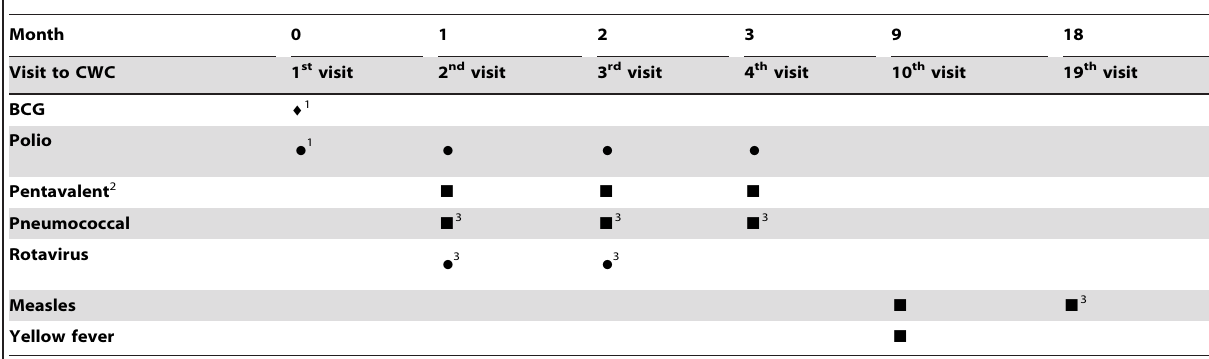
Table 1. Ghana vaccination calendar